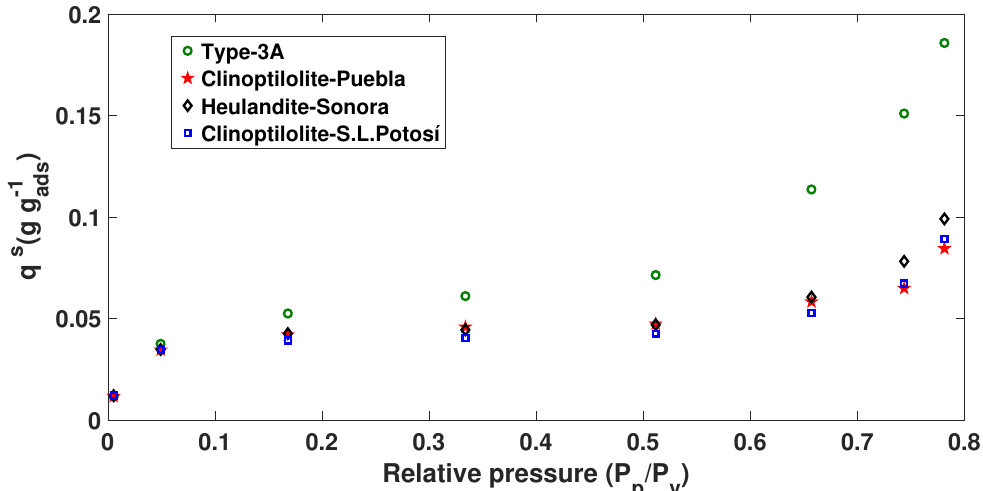
Figure 2. The 23 ◦ C adsorption isotherm ( H 2 O / H 2 SO 4 mixture) of Brunauer–Emmett–Teller (BET).